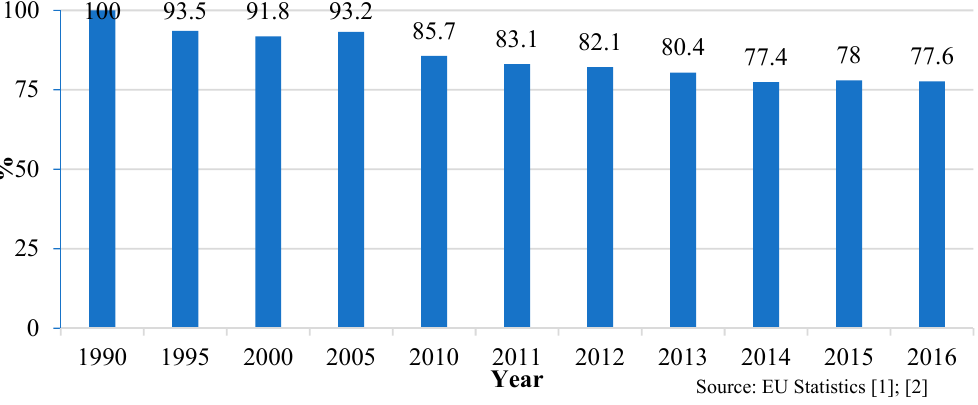
Figure 1. Greenhouse gas emissions (GHE) of the European Union (EU) countries relative to